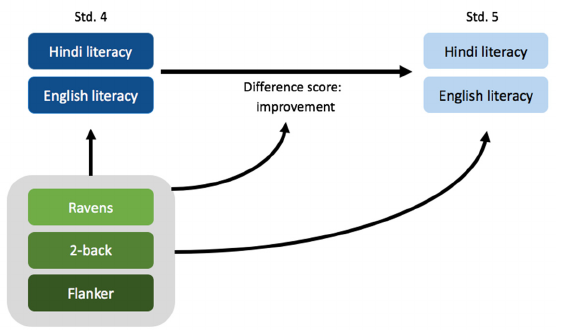
Figure 1. Setup of the study at two time points (Std. 4 and Std. 5), with the ASER literacy task as well as the three cognitive tasks being performed in Std. 4 and the ASER literacy task being performed in Std. 5.